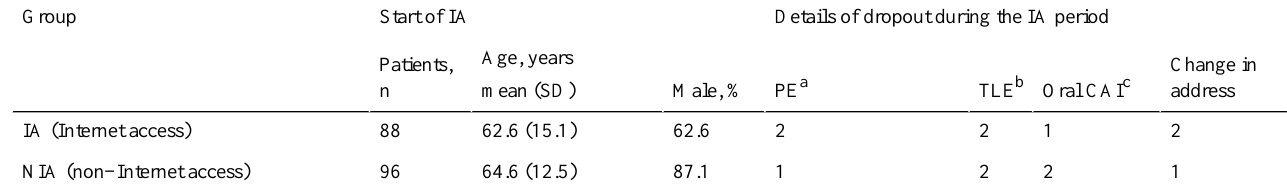
Table 1. Characteristics of all enrolled patients.